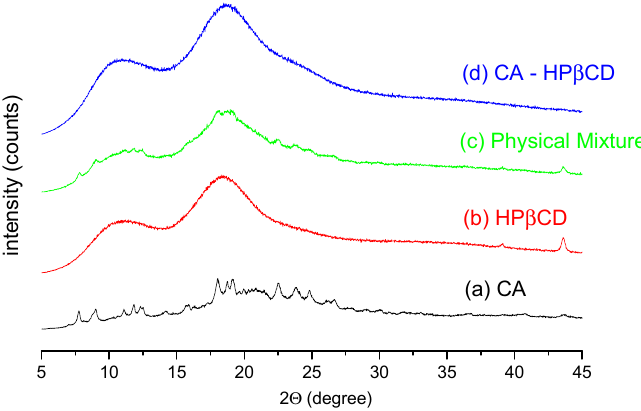
Figure 7. XRPD diffraction patterns of CA ( a ), HP β CD ( b ), physical mixture of CA–HP β CD ( c ), and prepared system ( d ).